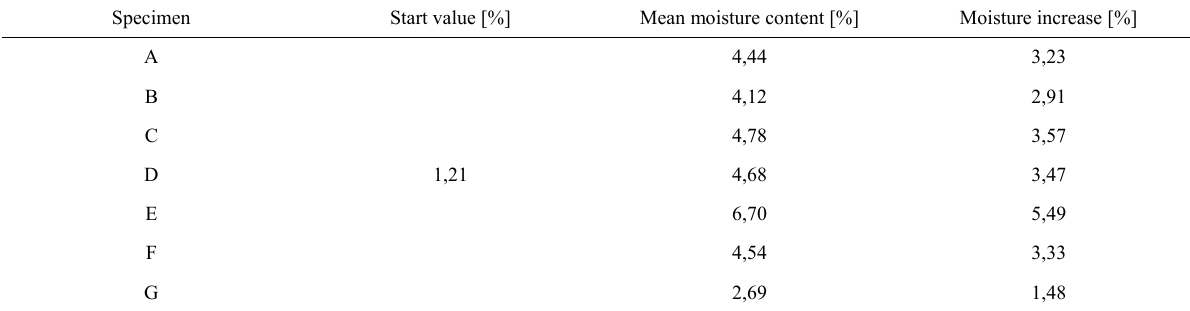
Table 4: Average moisture content in the desiccant of the insulating glass units after the artificial ageing Specimen Start value [%] Mean moisture content [%] Moisture increase [%]